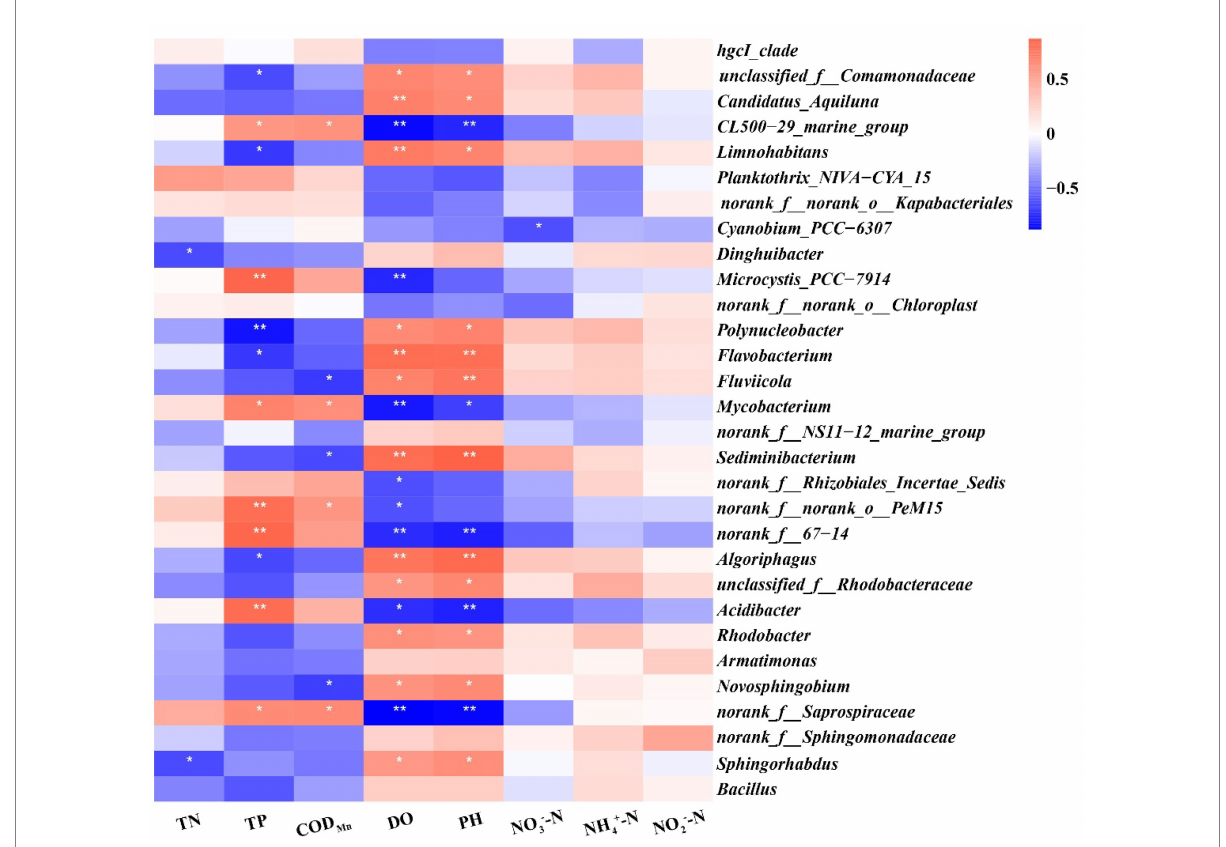
FIGURE 9 Correlation heatmap between eight physicochemical parameters and 30 important genera with differential abundance. Different shades of colors represent correlation level, with lighter shades indicating lower correlation and darker shades indicating higher correlation; red represents positive correlation and blue represents negative correlation. * p < 0.05; ** p <